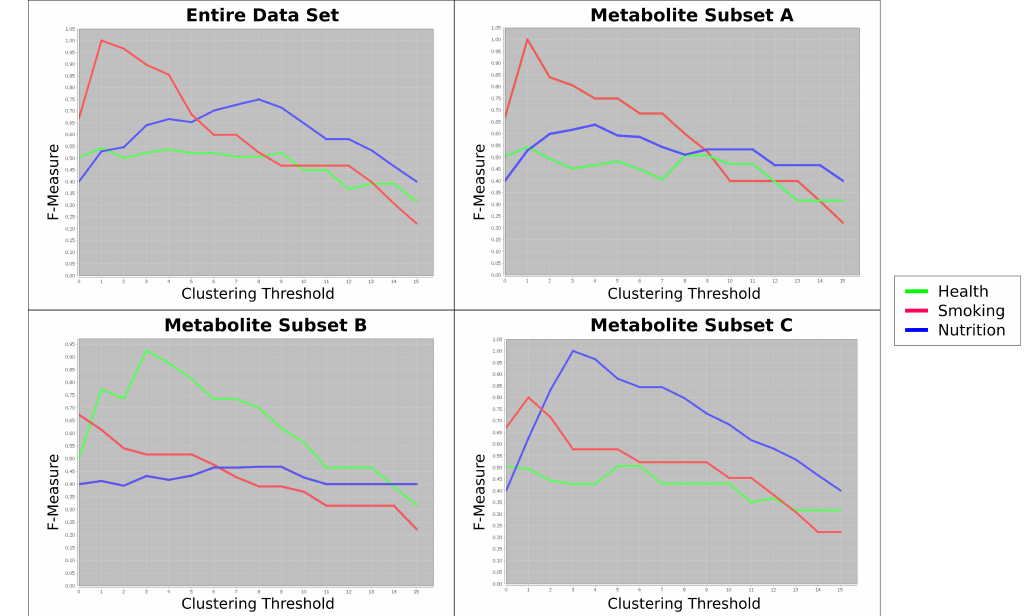
Figure 4. Carotta’s final output. The top left plots show the F-measure for